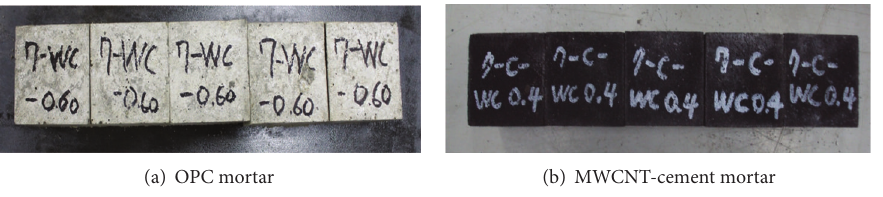
Figure 3: Photographs of the mortar